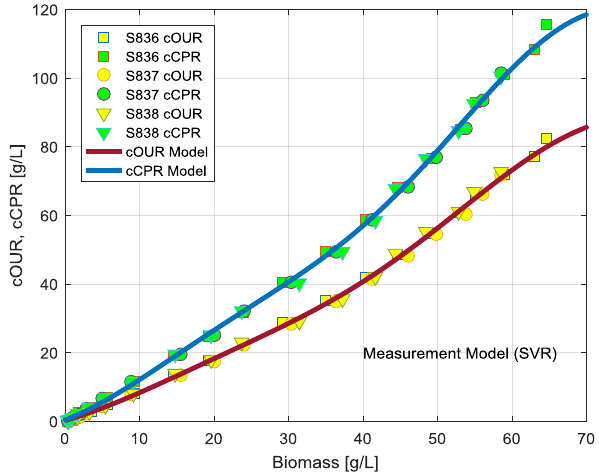
Figure 2. Cumulative oxygen uptake and carbon dioxide production rates signals as a function of the biomass concentration X . The curves show a direct evaluation of the support vector regression (SVR) model trained on the data of the cultivations S836, S837, and S838 [14] using the cross validation techniques. cOUR, cumulative oxygen uptake rate; cCPR, cumulative carbon dioxide production rate.